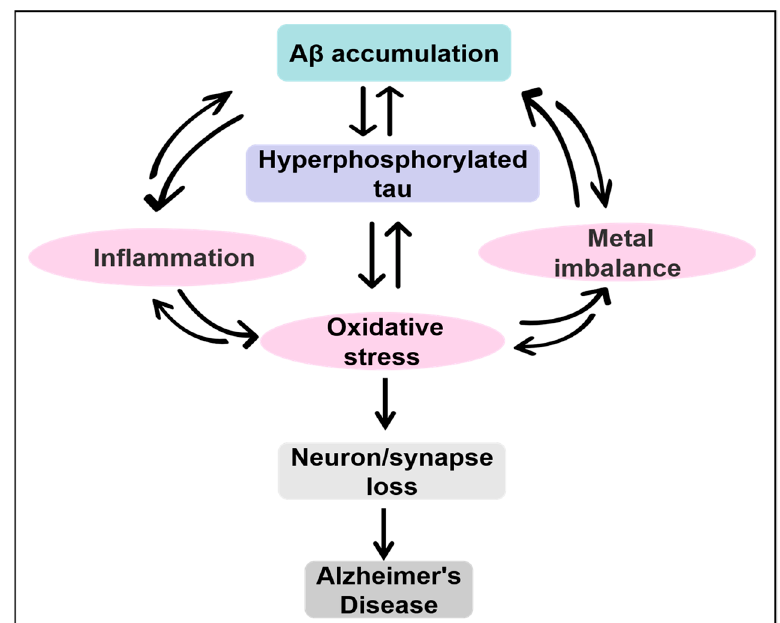
Figure 1. Mechanism of AD pathogenesis. AD is a disease caused by multiple factors, such as A β accumulation, hyperphosphorylated tau, oxidative stress, inflammation, metal imbalance, etc. These factors promote one another and form a feedback loop mechanism. Among all the factors, A β accumulation and hyperphosphorylated tau are the two main diagnostic indicators of AD and are the main substances that cause the occurrence of AD.